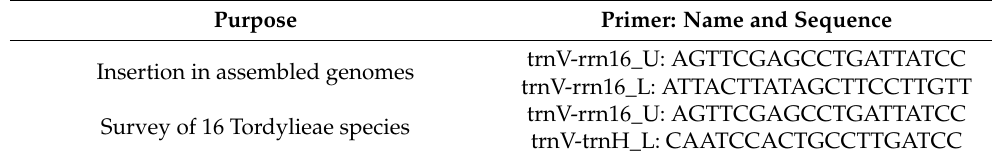
Table 4. Primer sequences used for amplification and